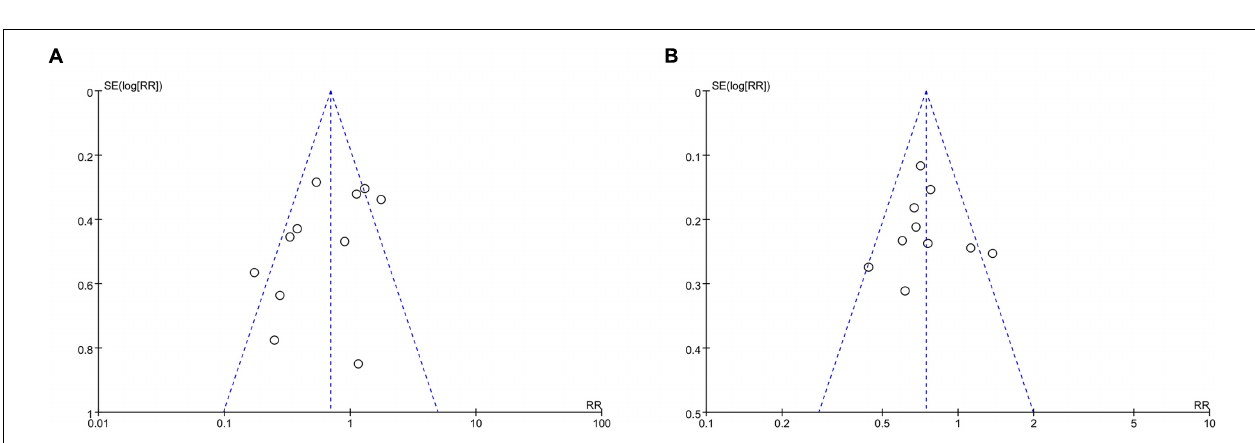
FIGURE 8 | Funnel plot for the publication bias. (A) PEP. (B)